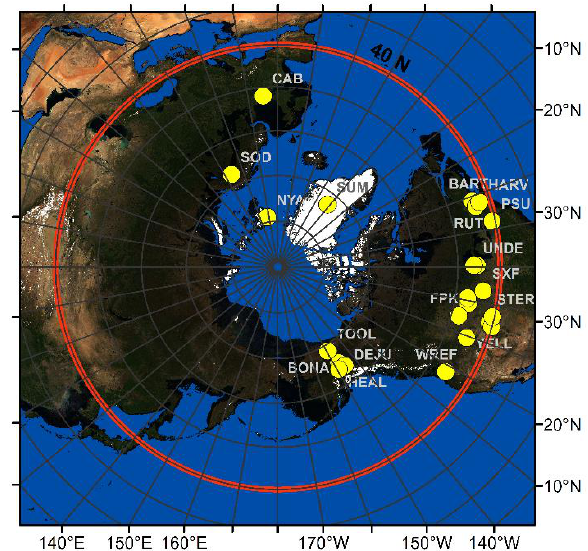
Figure 1. Validation tower sites used in this assessment with the red line indicating the product extent above 40N.